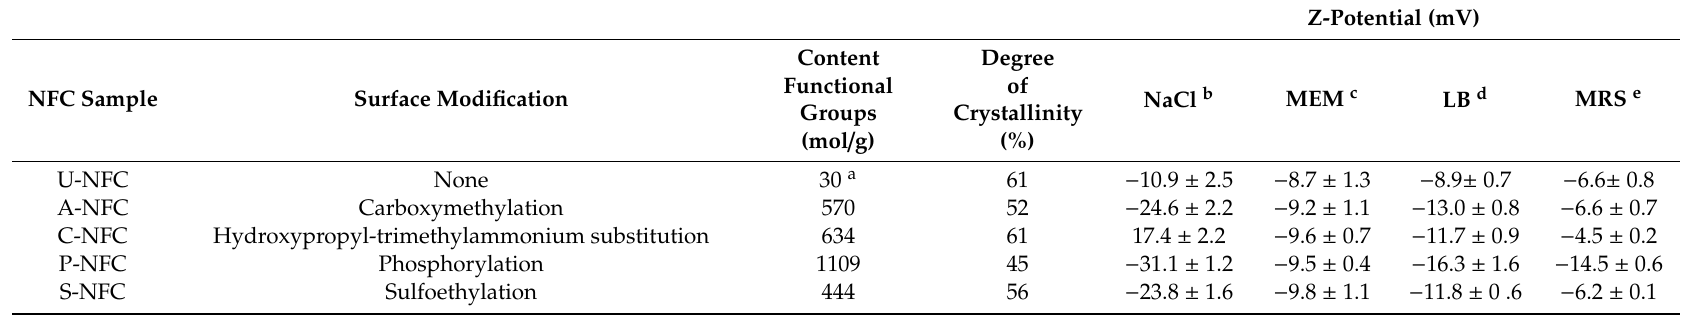
Table 1. Characteristics of the NFC materials under